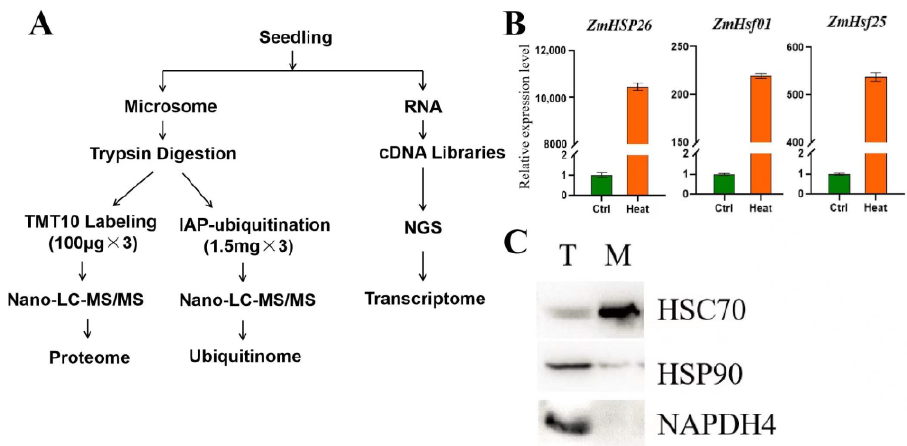
Figure 1. Experimental design and sample treatment: ( A ) Workflow for the experiment. Maize seedlings were subjected to heat stress. Total RNAs were used for RNAseq and microsomes were applied for proteome and ubiquitylome analyses. NGS, Next-generation sequencing; LC-MS/MS, liquid chromatography–tandem mass spectrometry; IAP, immuno-affinity purification; ( B ) qRT-PCR for maize HSR genes; and ( C ) purity of microsome fraction. HSC70, representative endoplasmic reticulum protein; HSP90, representative cytosol protein; NAPDH4, representative mitochondrion protein; T, total protein; M, microsome